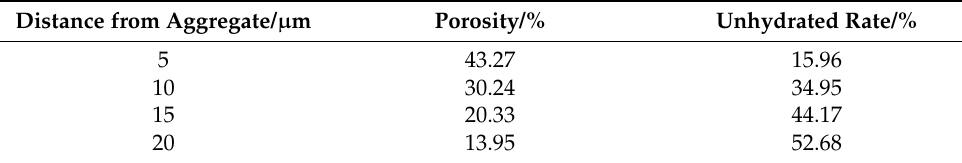
Figure 10. Quantitative calculation of the interfacial transition zone: HPMC1 ( a ) and HPMC0 ( b ) at 28 days. Table 8. BSE quantitative calculation of HPMC0.